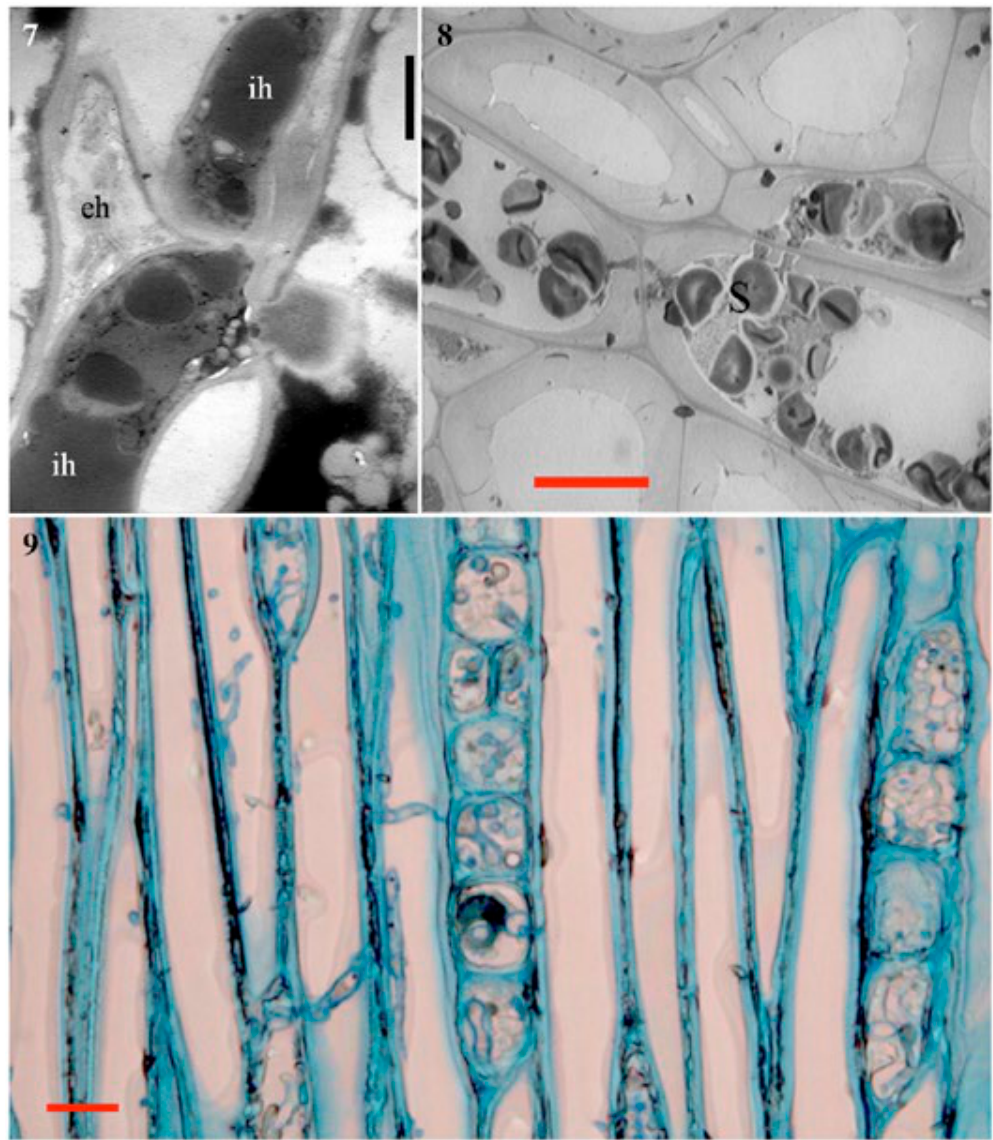
Plate B. Figure 7. Hypha in woody tissues with degenerated cytoplasm and septa. Another hypha enters the outer hypha, and develops inside. Figure 8. Control woody sample. The ray’s parenchymatic cells with deposition of a secondary wall and cytoplasm rich in starch grains. Figure 9 . Xylematic zone. The ray’s parenchymatic cells and fibres are colonised by hyphae. Light microscopy. (fungal structures: eh, external hypha; ih, intrahyphal hypha; plant structures: S, starch grains; black bar, 1 µm; red bar, 5